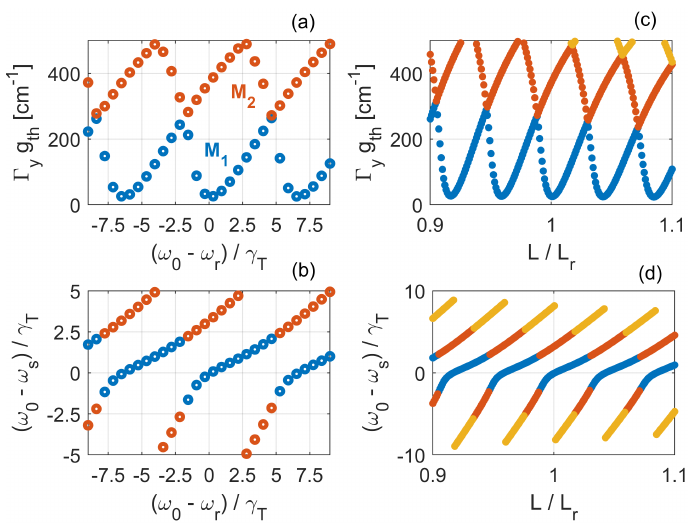
Figure 14. ( a , c ) Threshold modal gain and ( b , d ) effective detuning of the Fano laser upon tuning of ( a , b ) the nanocavity resonance frequency and ( c , d ) cavity length. The lasing mode, M 1 , is in blue. The second and third-order modes are in red and yellow,